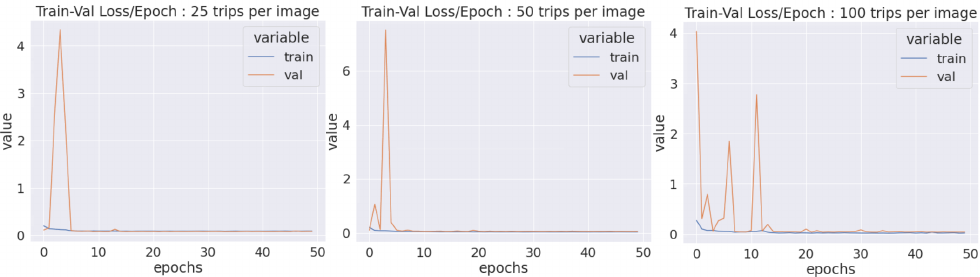
Figure 8. Training (blue) and validation (orange) losses per epoch for CNN_25 ( left ), CNN_50 ( middle ) and CNN_100 ( right